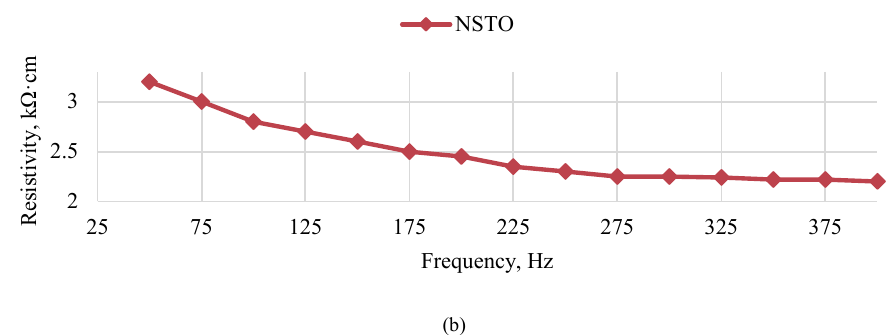
Fig. 5. Resistivity changes in relation to frequency: a) Mineral oil; b)